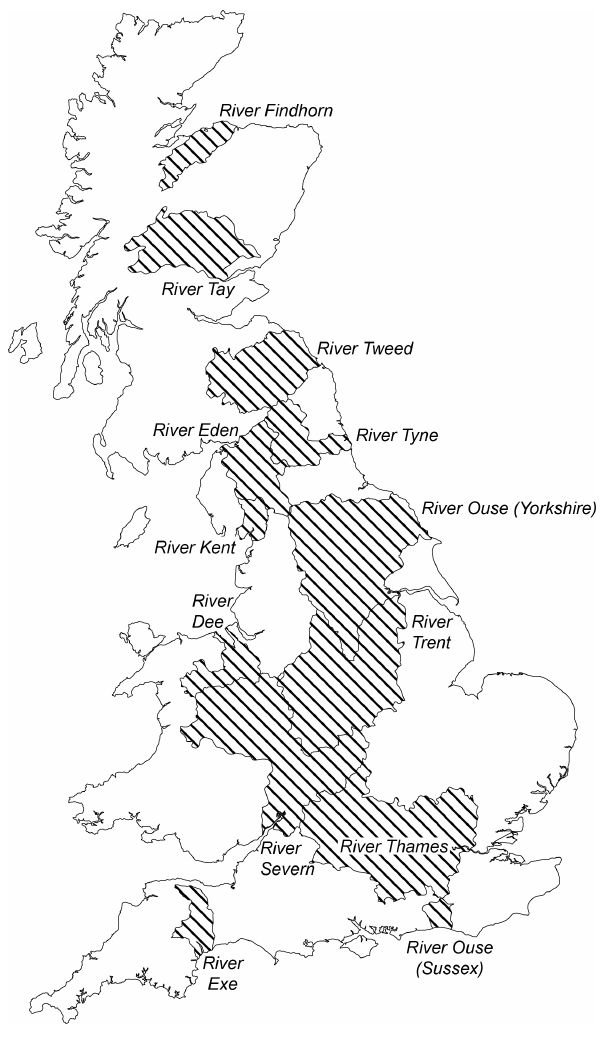
Figure 1. Catchments for which historical flood reconstruction has been undertaken, county names are added in parentheses where multiple catchments exhibit the same